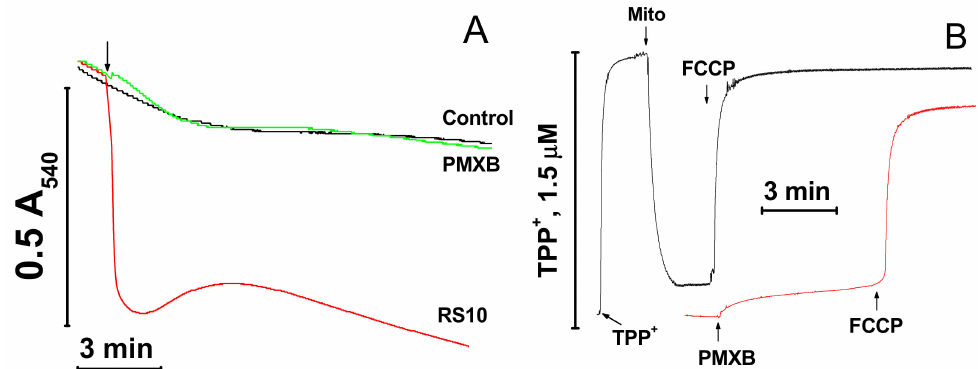
Figure A1. E ff ect of polymyxin B on mitochondrial swelling ( A ) and ∆Ψ m ( B ). ( A ) Mitochondria (0.5 mg prot. / mL) were added to a standard KCl-based medium supplemented with 5 mM succinate (plus 2 µ g / mL rotenone) immediately before measurements. The arrow indicates the addition of the RS10 extract (10 µ g / mL) and polymyxin B (PMXB) (100 µ g / mL). ( B ) Arrows show the addition of 1.5 µ M TPP + (tetraphenylphosphonium chloride), mitochondria (1.5 mg prot. / mL) (Mito), polymyxin B (100 µ g / mL) (PMXB), and 500 nM FCCP. The figure shows the original traces of one standard experiment of three